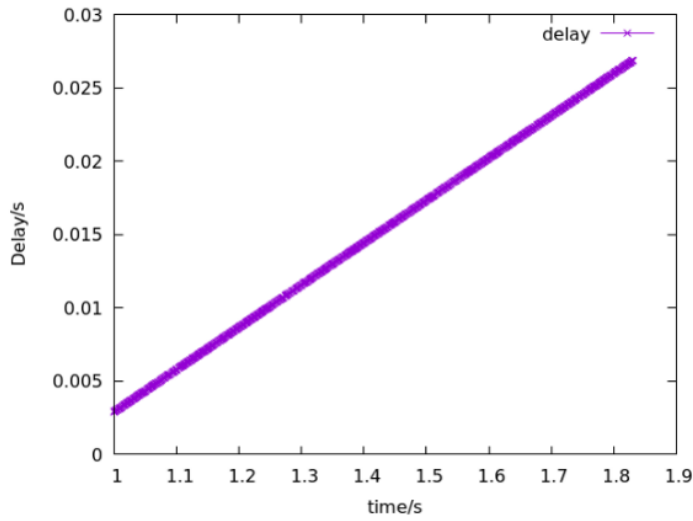
Figure 8. Delay of traditional network.